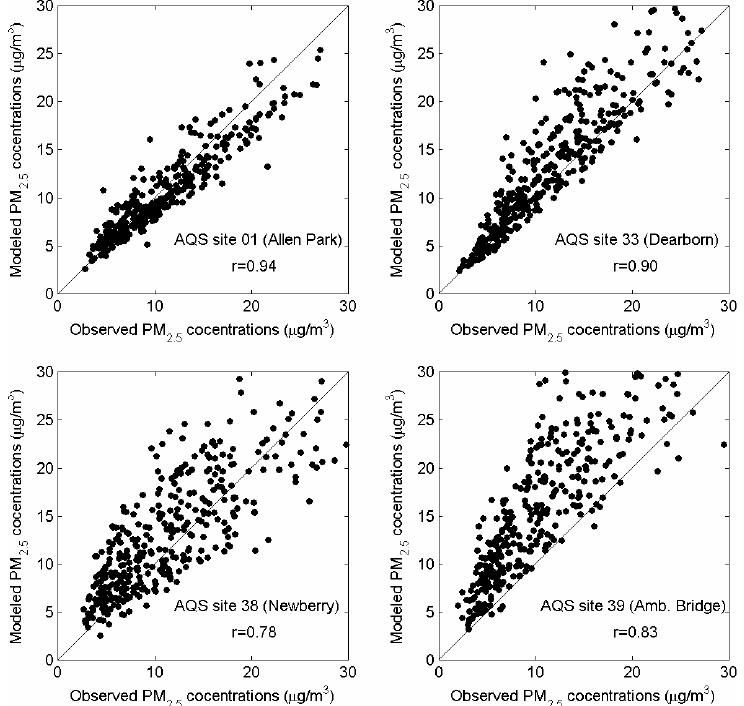
Figure 4. Model to monitor comparison: daily average PM period of 2010 at four AQS sites in the Detroit modeling domain.